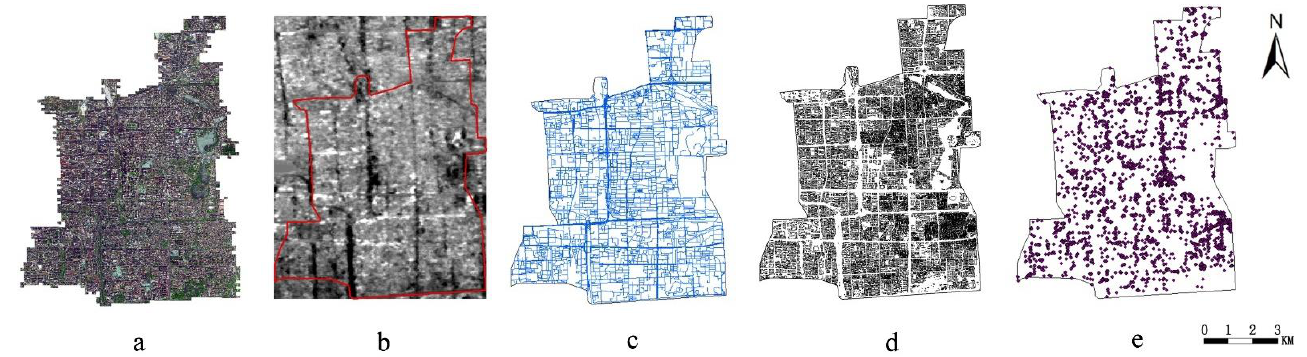
Figure 1. The five types of data used for the evaluation of the study area. ( a ) The remote sensing image; ( b ) Digital elevation model data; ( c ) Road distribution data; ( d ) Buildings’ outline data; ( e ) Point of Interest (POI) data.